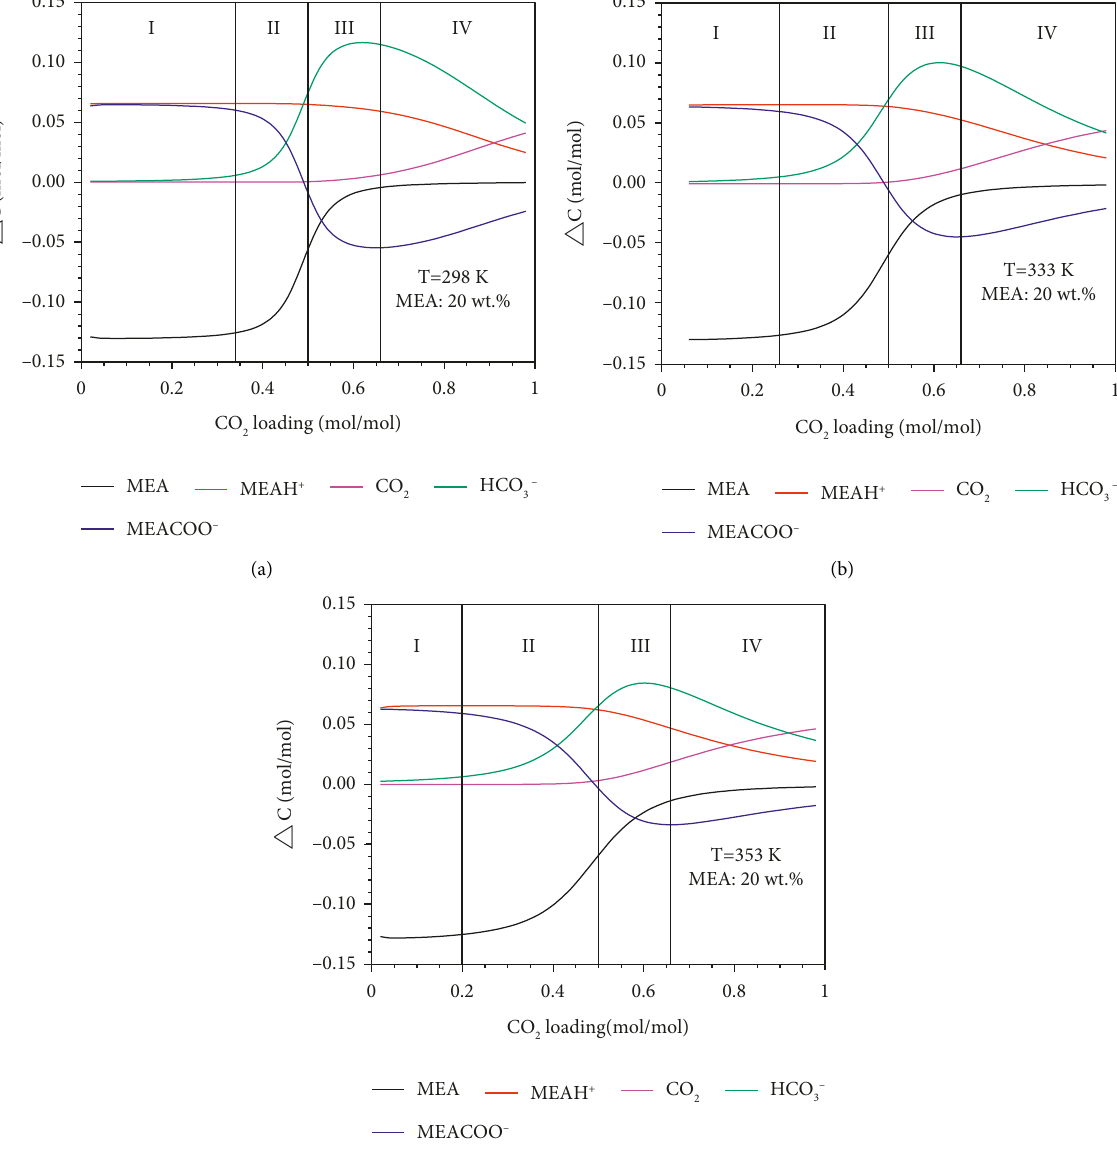
2 loading at different temperatures (a) T (b) T � 333K; and (c) T � 353 K.